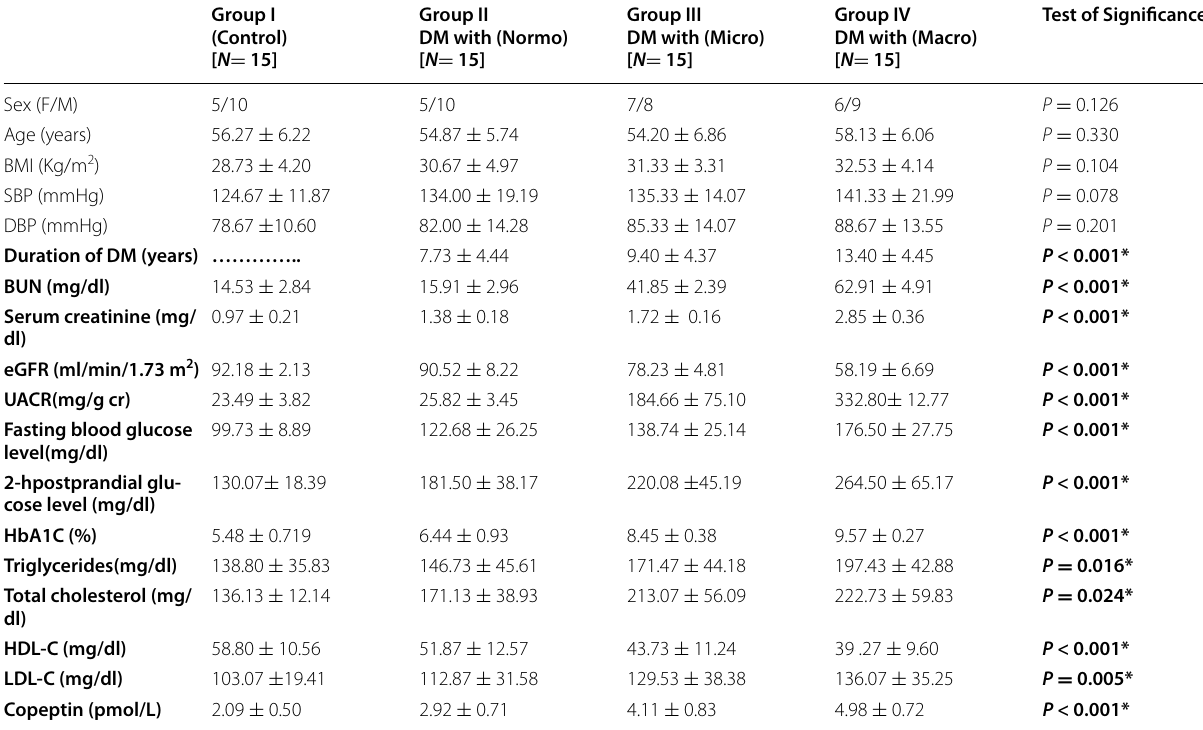
Table 1 Clinical and laboratory parameters of the studied groups